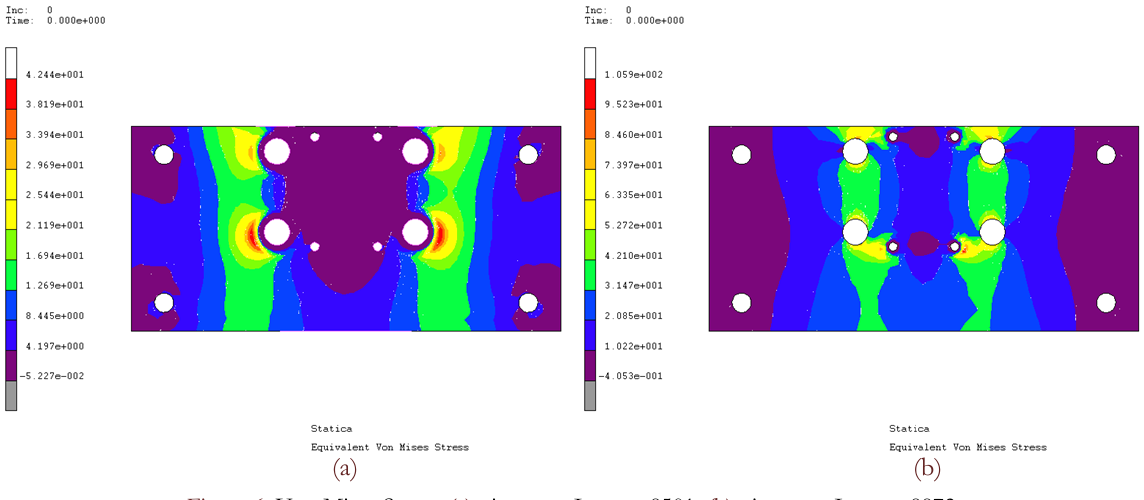
Figura 6: Von Mises Stress; (a) piastra su Instron 8501; (b) piastra su Instron 8872 Elementi membrana quadrangolare 2D; spessore 25mm; materiale